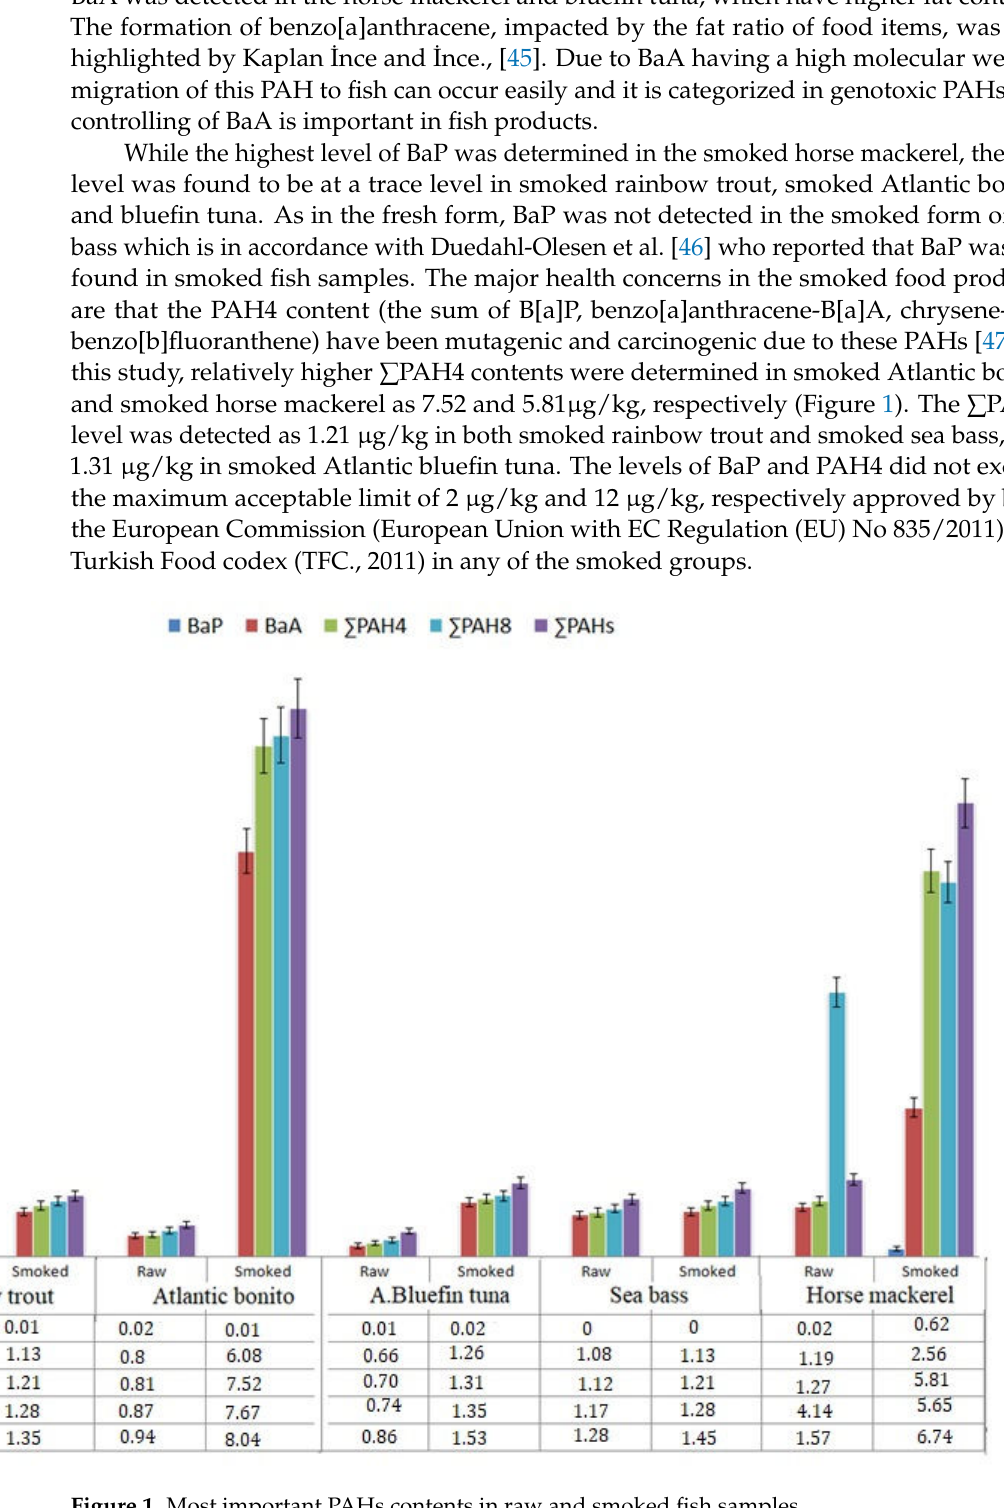
Figure 1. Most important PAHs contents in raw and smoked fish